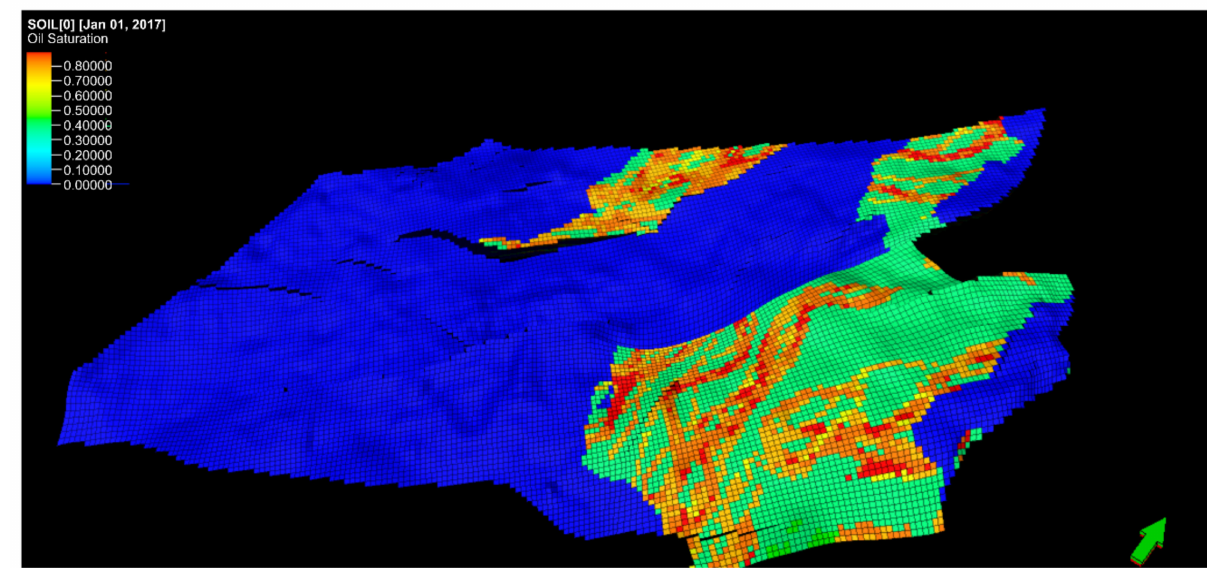
Figure 6. Oil saturation (fraction) in the B27 reservoir in the J1 Oilfield. The change in color toward red indicates increasing oil concentrations, while the change in color toward blue indicates increasing water